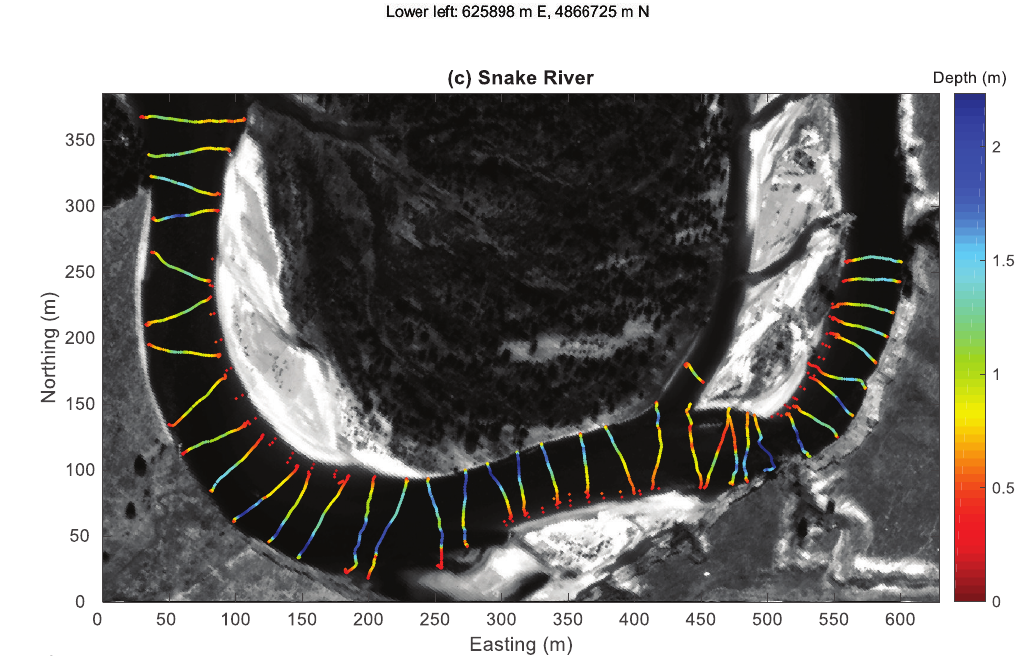
Figure 2. ( a ) location of Deschutes River and Snake River study areas within the western United States. Depth measurements from ( b ) the Deschutes River, acquired with a multibeam echo sounder; and ( c ) the Snake River, acquired by wading and with an Acoustic Doppler Current Profiler (ADCP). For both sites, the background is a red band (675 nm) of the hyperspectral image. The flow direction is from bottom to top in ( b ) and from right to left in ( c